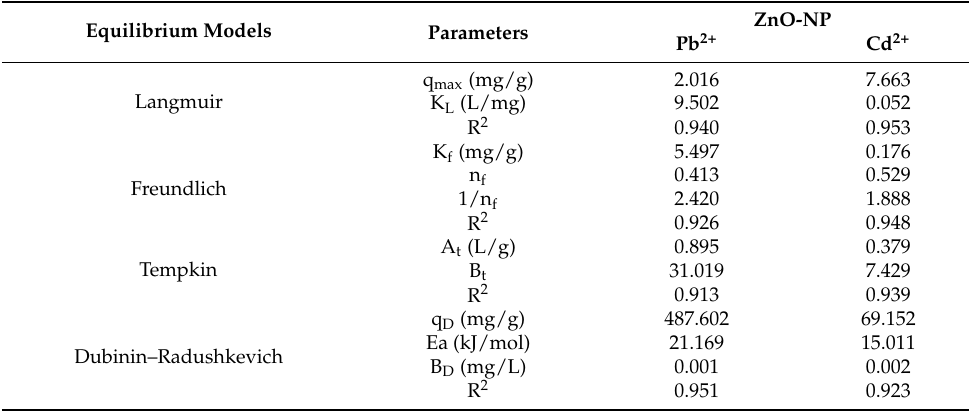
Table 4. Linear adsorption isotherm parameters for the Cd 2+ and Pb 2+ .ion adsorption